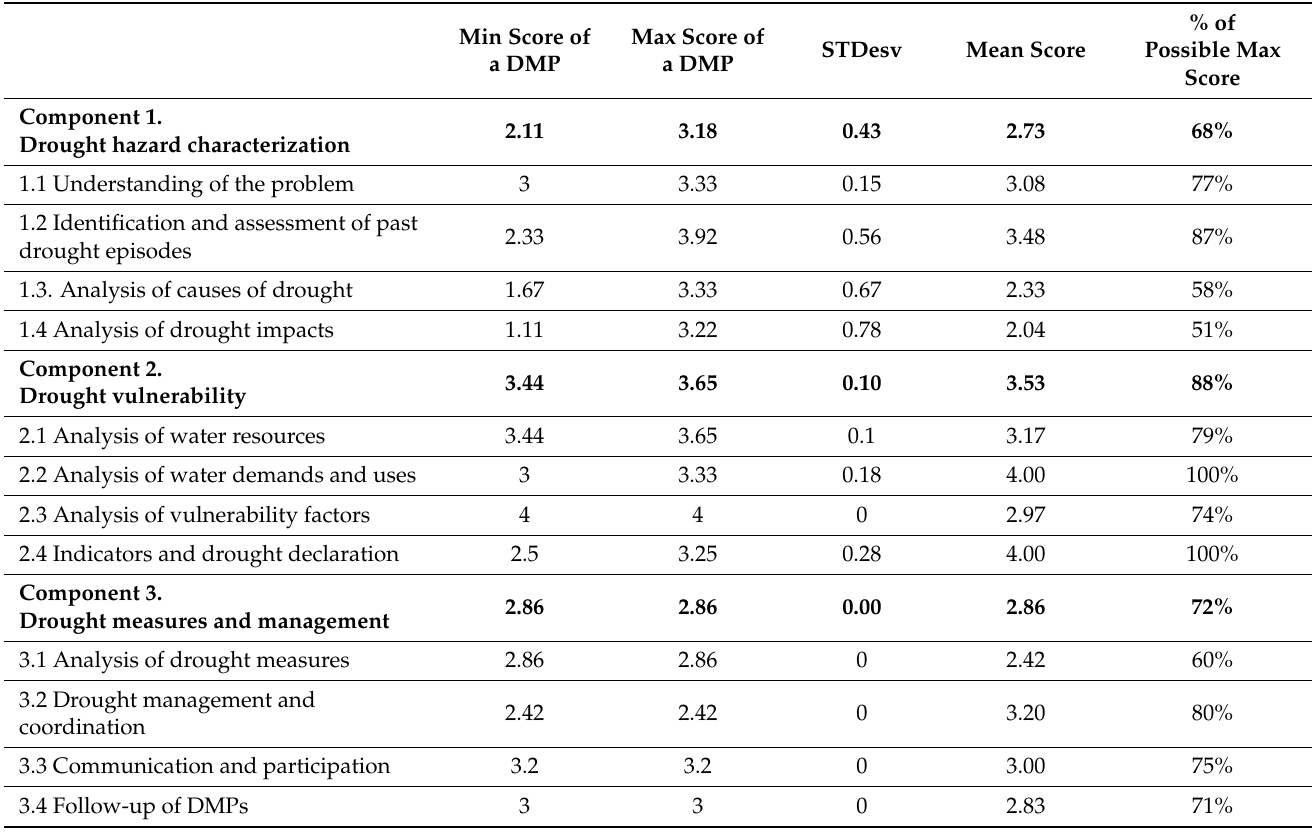
Table 3. Results for each component and criteria by